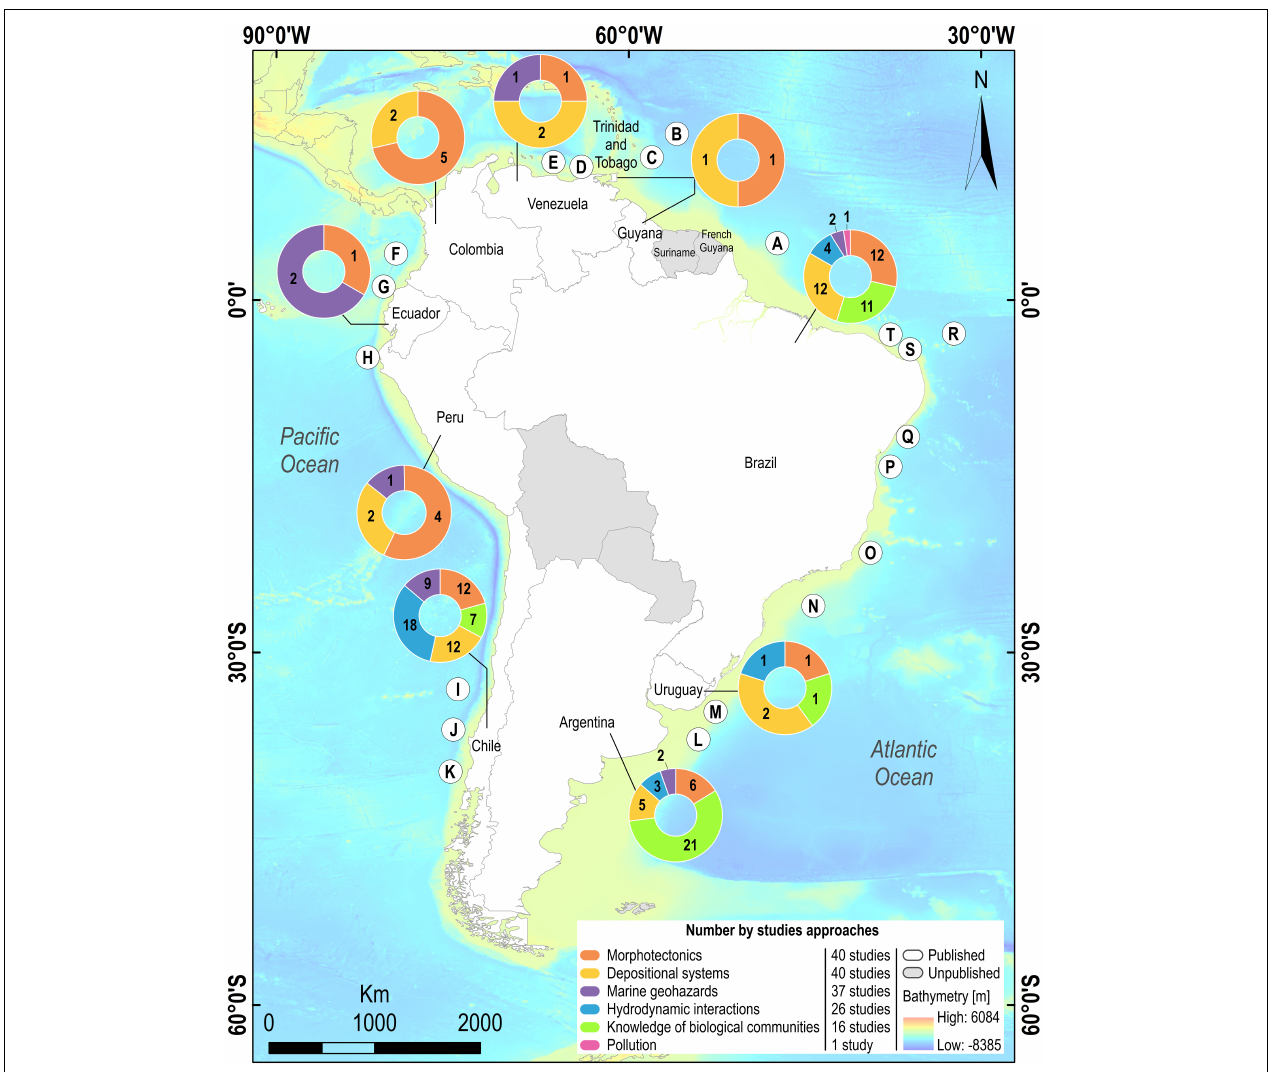
FIGURE 5 | Spatial distribution map of studies on submarine canyons areas (letters) in South America with emphasis on the number of publications by different specificities data with countries in white that have published and in gray that did not publish. (A) Amazon. (B) Vidal Deep-Sea. (C) Darien Ridge. (D) Manzanares. (E) Los Roques. (F) Patia/Mira/Esmeraldas/La Aguja. (G) Santa Helena/Guayaquil. (H) Paita/La Bocana. (I) San Antonio/Rapel/Mataquito/Maule/Itata. (J) Biobio/Lleulleu/Imperial/Toltén/Lingue. (K) Callecalle/Chaihuin/Chacao/Cucao. (L) Mar Del Plata/Ameghino. (M) Ignacio. (N) Almirante Câmara/Grussai/Rio Doce/Watu Norte/São Tomé. (O) Regencia. (P) Salvador/Itacaré/Almada/Uma/Canavieiras. (Q) São Francisco/Japaratuba. (R) Equatorial Mid-Ocean/Fernanado de Noronha Arquipélago. (S) Grossos/Areia Branca/Mossoró/Apodi/Ponta do Mel. (T) Ponta do